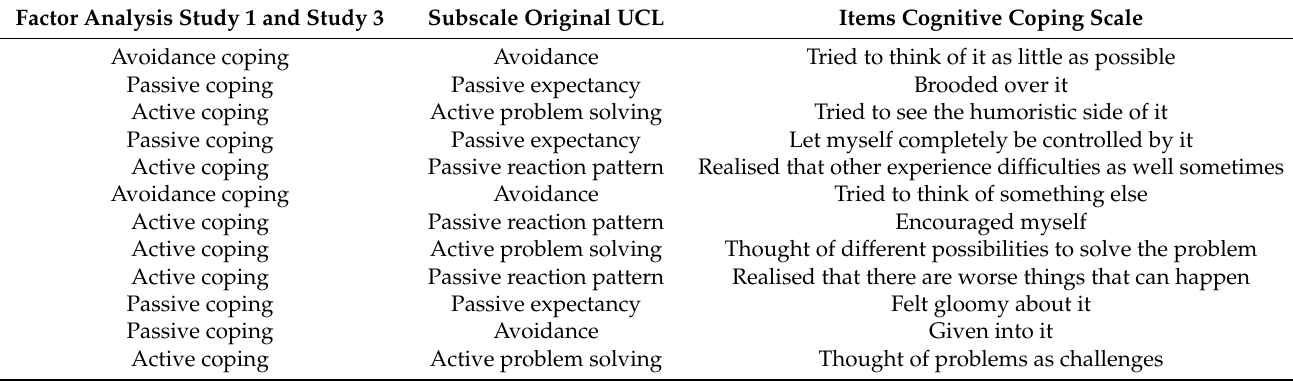
Table 1. Overview of the State Coping Scale (SCS) with the subscales for the present study and the original subscales of the Utrecht Coping